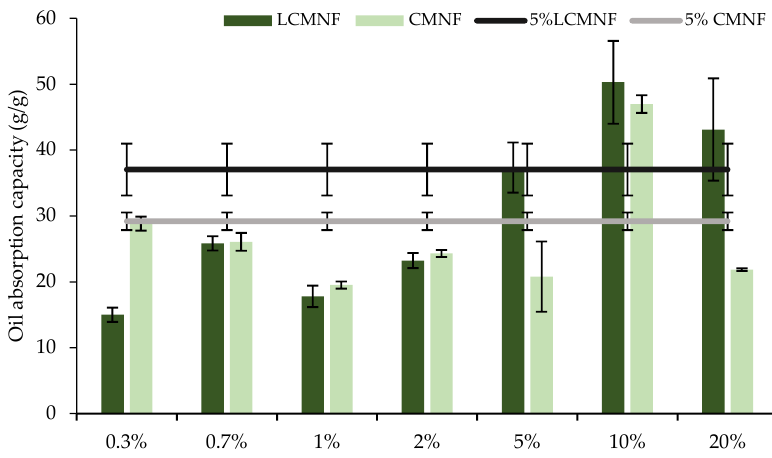
Figure 5. Water and soybean oil absorption capacities of bioactive LCMNF-CH and CMNF-CH aerogels.